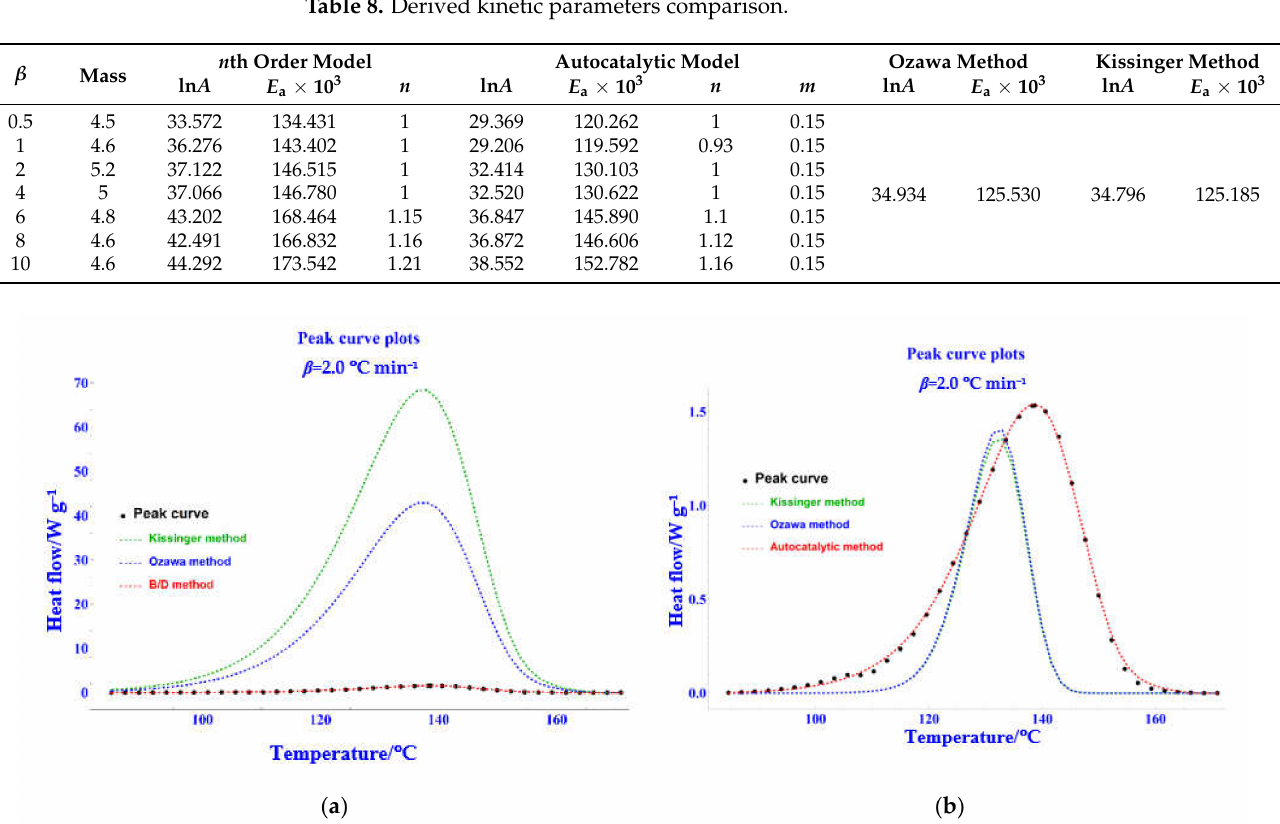
Figure 17. Comparison of n th kinetic model results. ( a ) n th-order versus the Ozawa and Kissinger method plots; ( b ) autocatalytic model versus the Ozawa and Kissinger method